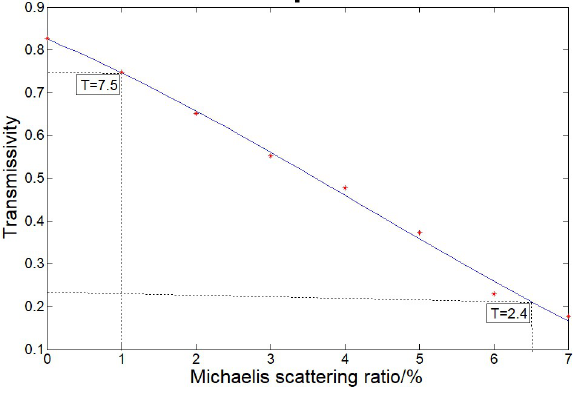
Fig 5 Transmissivity simulation of 6.5% Michaelis scattering Furthermore, we use the proportion of Michaelis scattering as an independent variable to simulate the transmissivity and and use the cubic spline interpolation method to make the fitting image. The simulation figure of transmissivity under Michaelis scattering ratio is shown in Fig. 6.